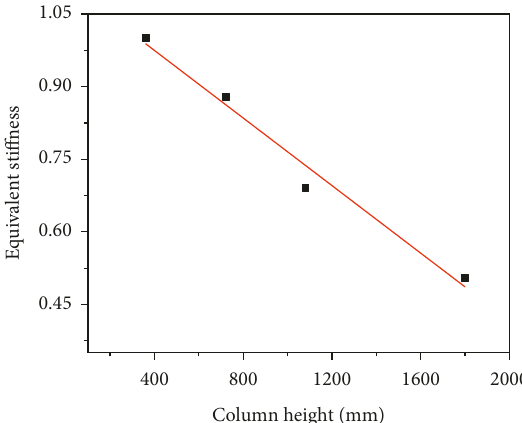
Figure 6: Variation trend of the equivalent